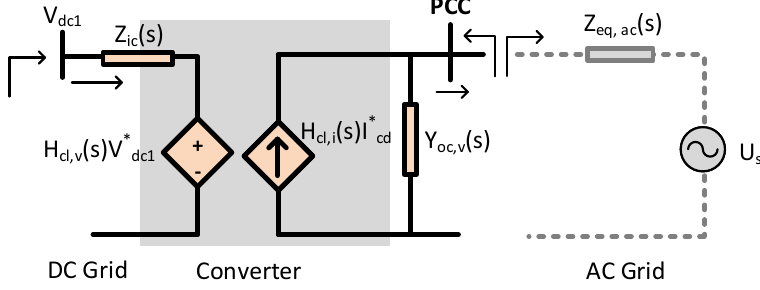
Figure 9. Equivalent circuit representation of converter relative to the